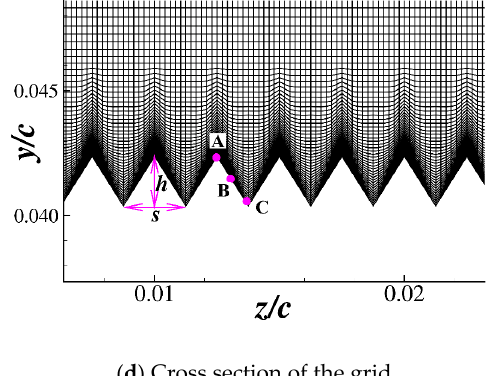
( d ) Cross section of the grid. Figure 7. Riblet configuration and computational grid.